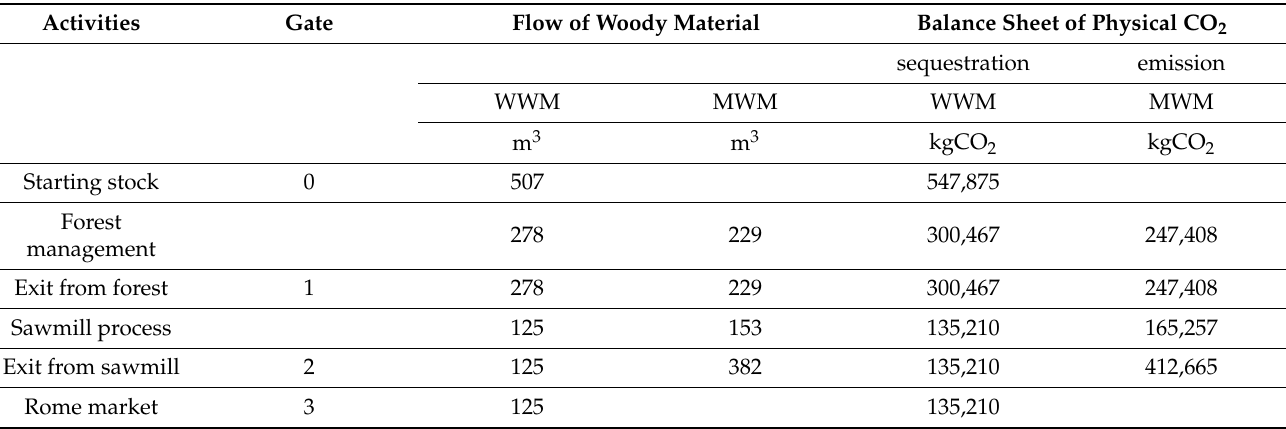
Table 11. Flow of chestnut wood material and physical balance sheet of CO 2 . Legend: WWM: Workable Wood Material, MWM: Minor Wood